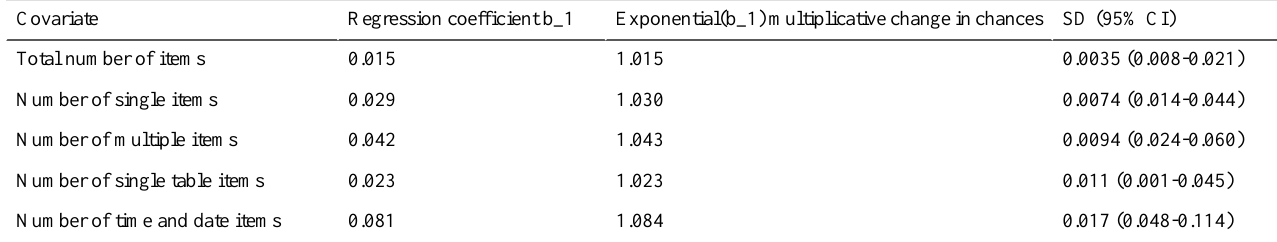
Table 3. Mixed model effect, ordinal logistic regression for the data collected by electronic data capture (EDC) and paper and pen data capture (PPDC) tools used during a survey in the demographic survey site in 2016, in Dabat, northwest